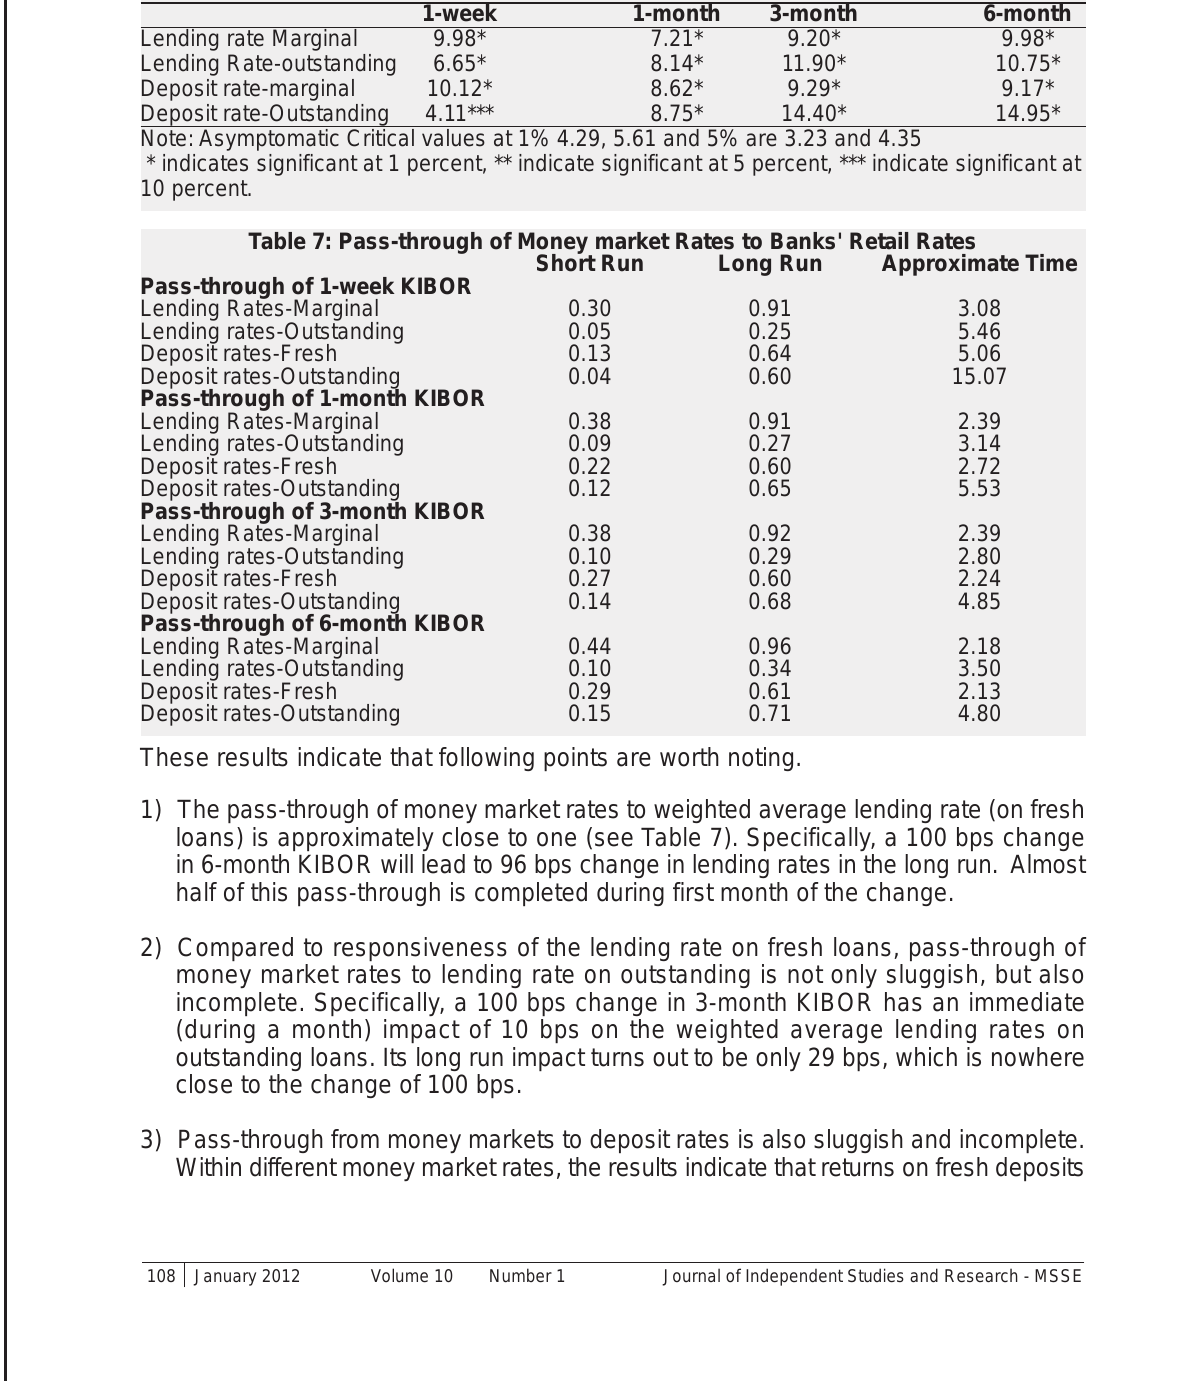
Table 6: F-Statistics for Testing Long Run Relationship F-Statistic